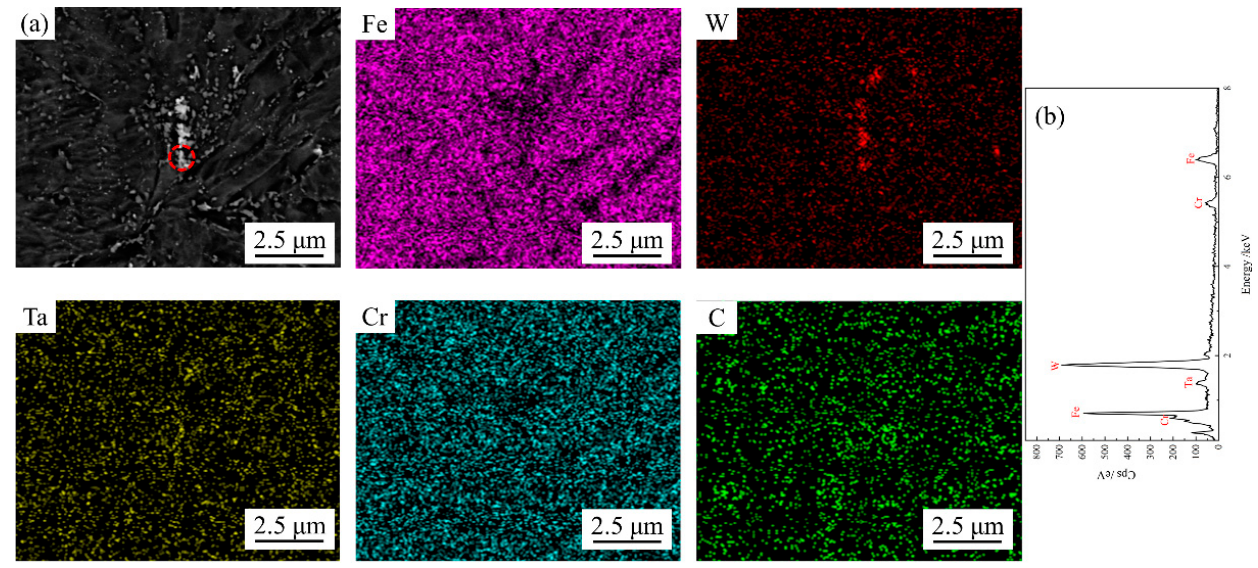
Figure 12. Surface scanning analysis ( a ) of 0.004ZrD aged for 1500 h, ( b ) corresponding result of point analysis of the area indicated in red circle in ( a ).